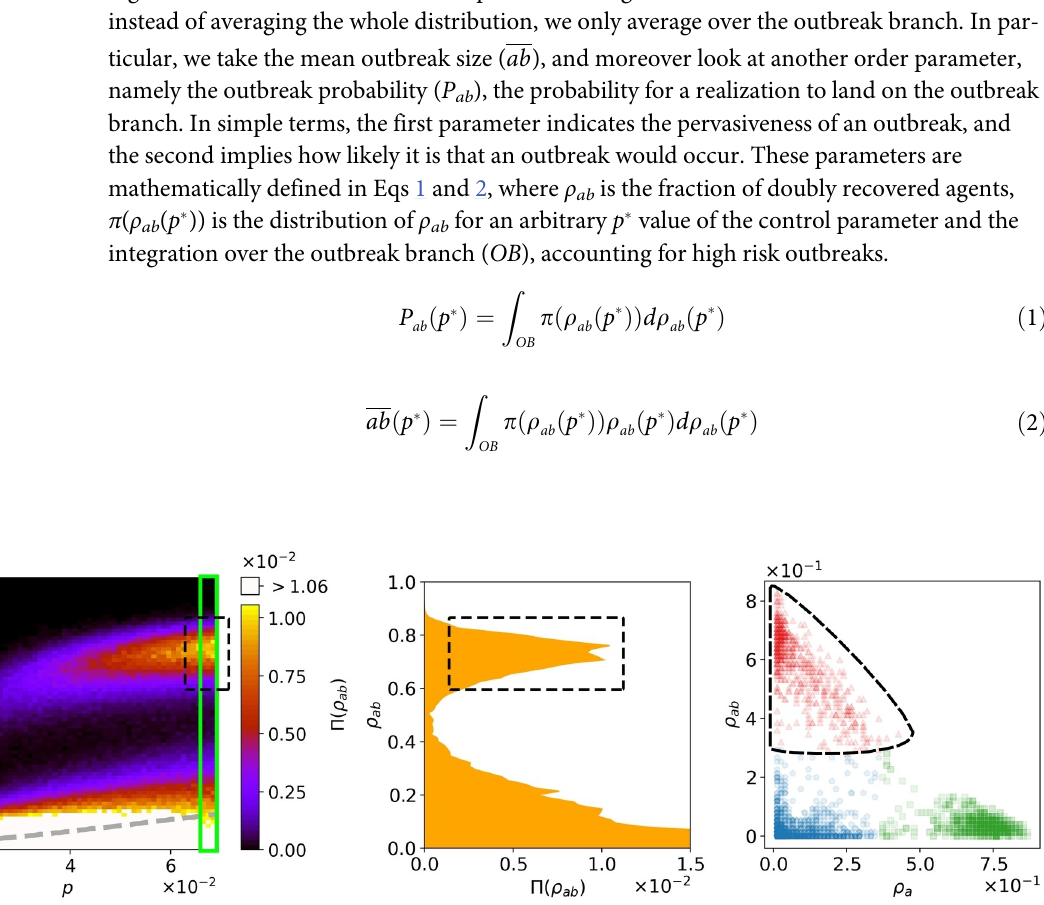
PLOS ONE | https://doi.org/10.1371/journal.pone.0253563 July 20,